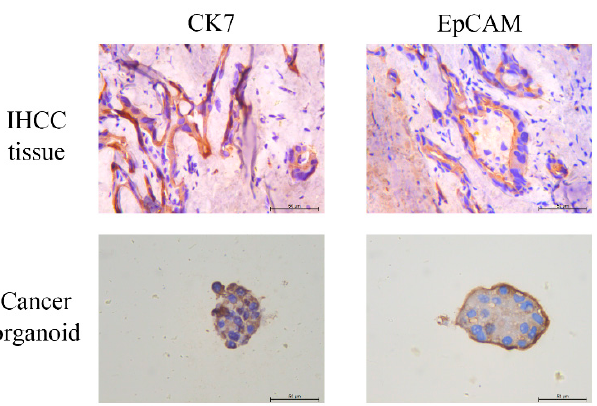
Figure 4. Immunohistological staining of IHCC tissue and cancer organoid, including CK7 and EpCAM. Scale bar, 50 µ M.